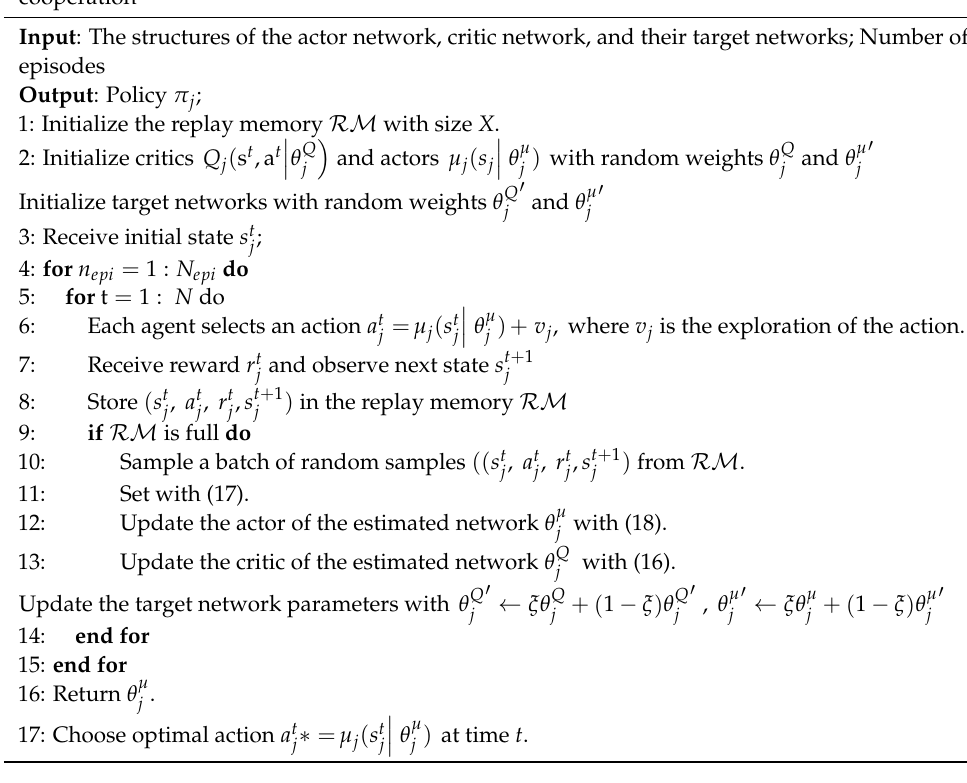
Algorithm 1: MADDPG-based multi-UAV power allocation algorithm based on energy